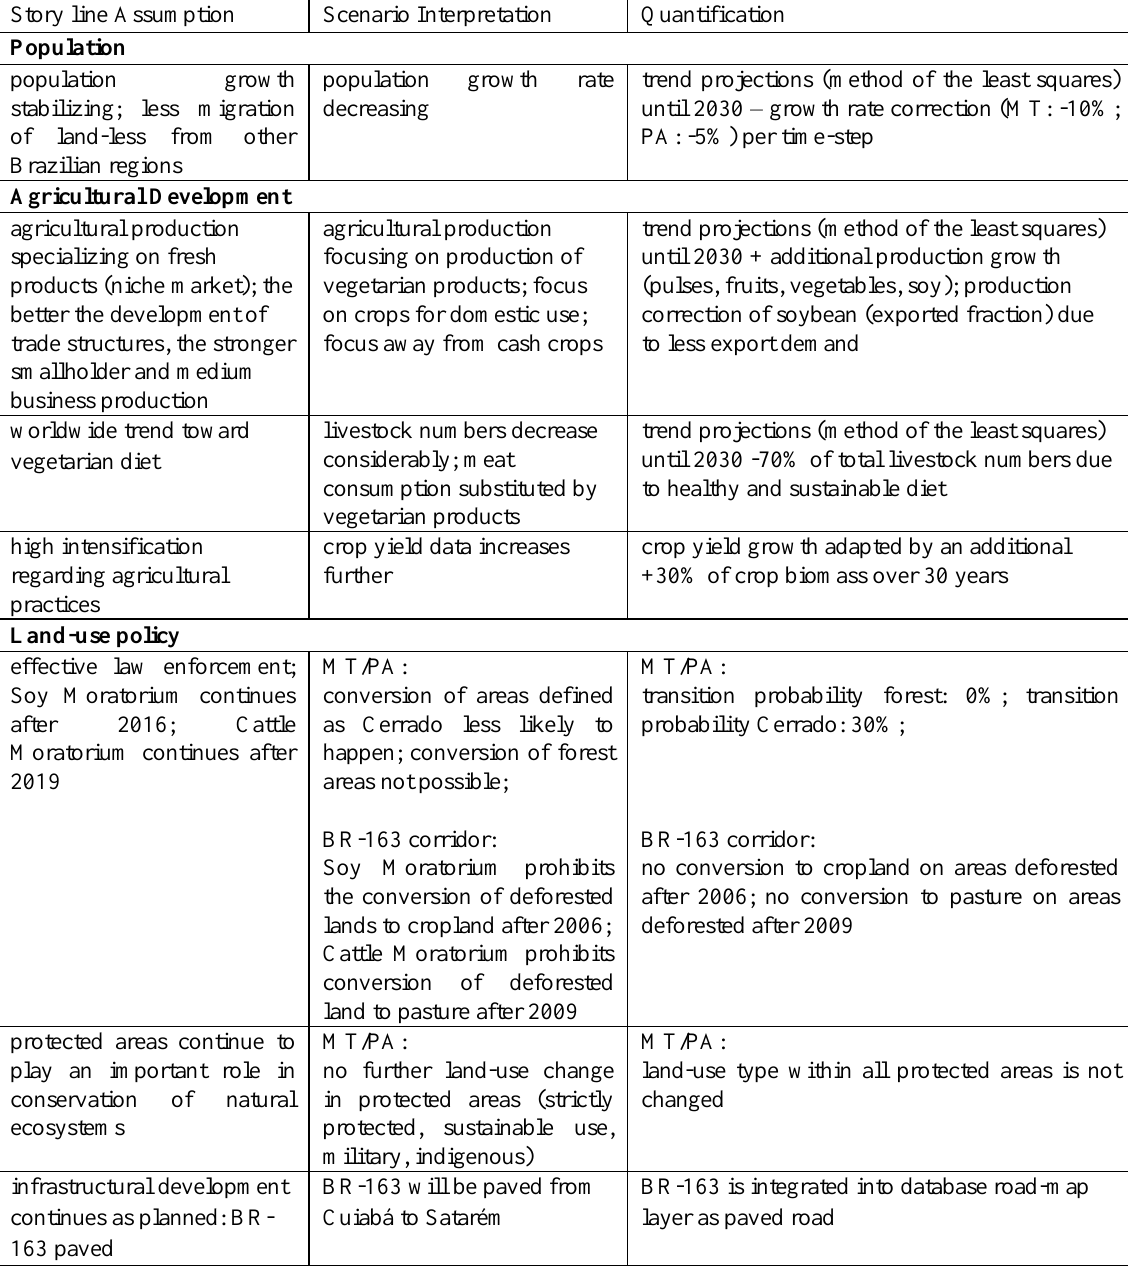
Table A1.4. Translation of story line statements to model drivers (Sustainable Development